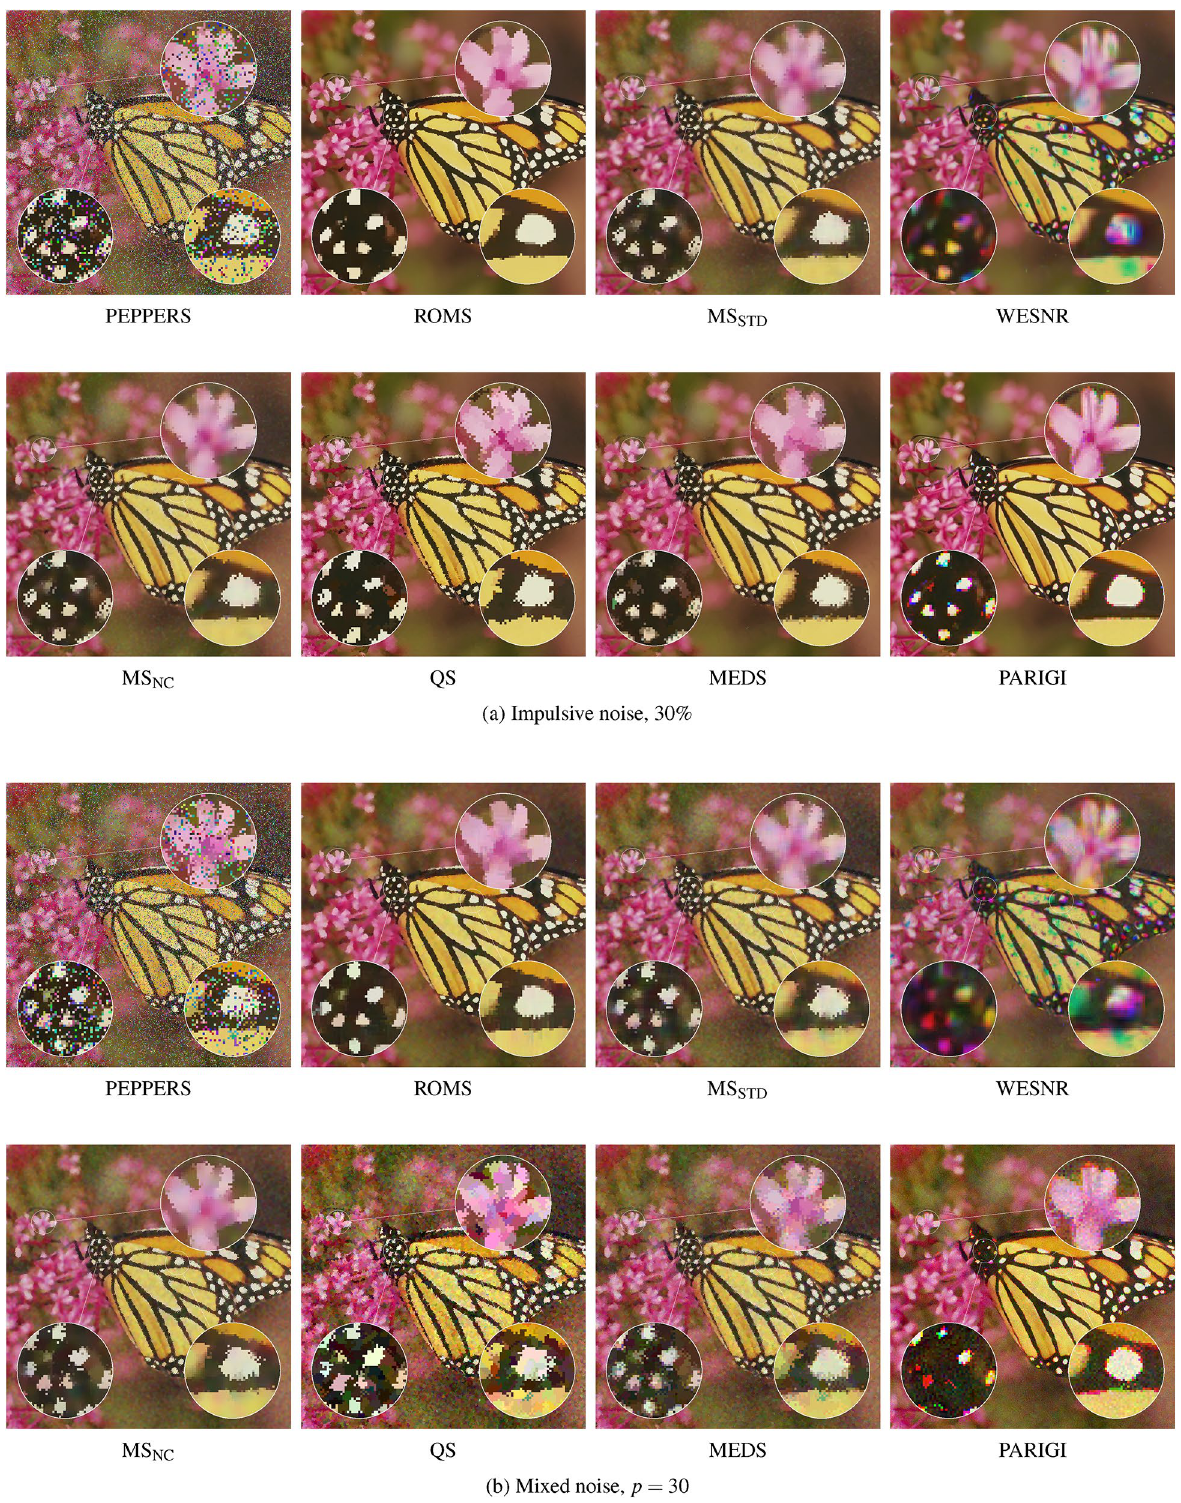
Figure 8. Efficiency comparison of the the proposed ROMS algorithm with the MS technique on MONARCH images contaminated with impulsive noise of 30% ( a ) and with mixed noise of intensity p = 30 ( b